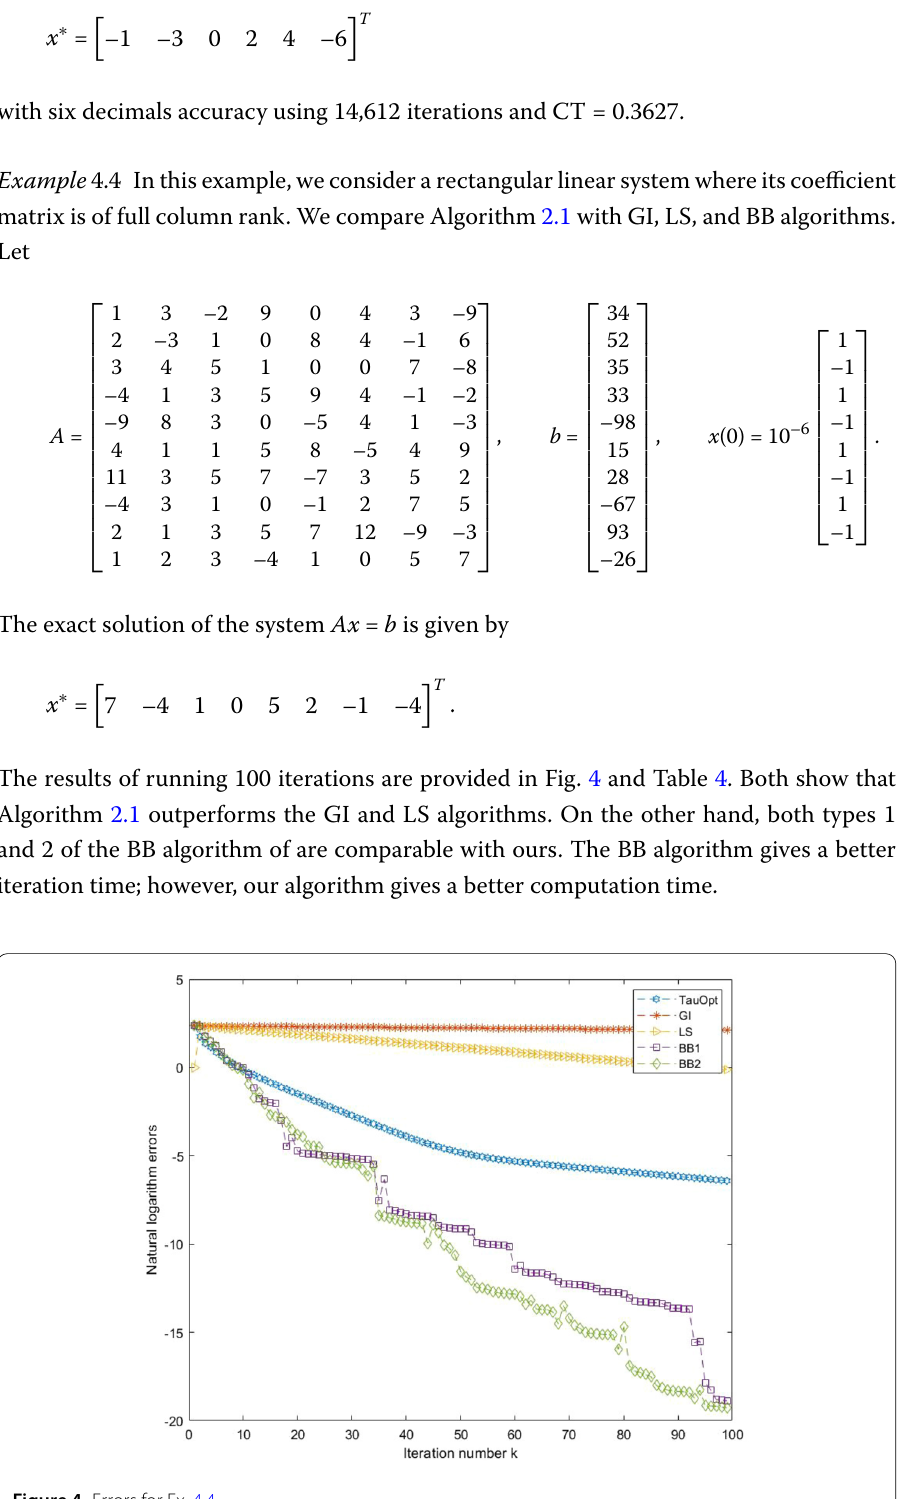
Figure 4 Errors for Ex.